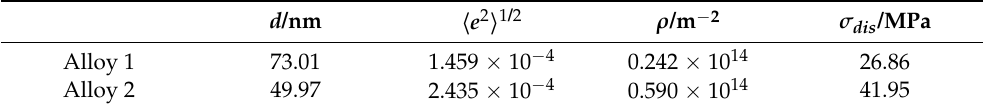
Table 6. Microstructural and mechanical features calculated from